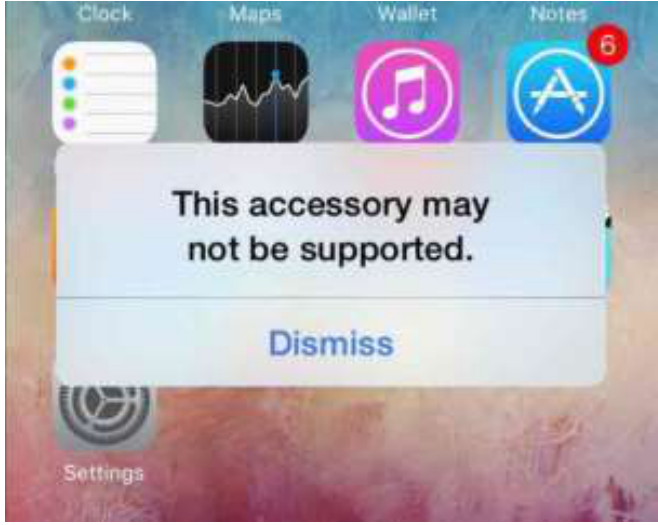
Figure 9. The error message that the current phone does not support the accessory if the cable is of poor quality.